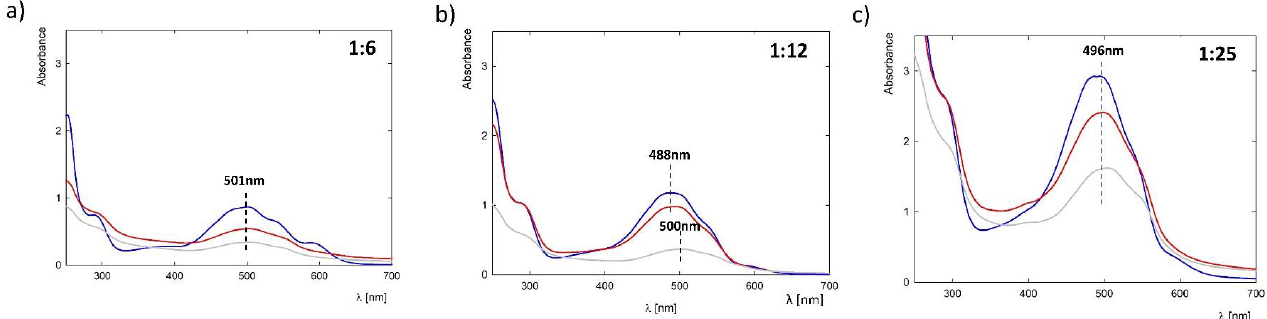
Figure 6. UV-Vis spectra of G4PAMAM-DOX complexes with pH 9.5 for selected G4PAMAM-DOX molar ratios: ( a ) 1:6, ( b ) 1:12, and ( c ) 1:24 (blue line: starting complex, red: 24 h of mixing, and gray: after dialysis). Table 2. Doxorubicin concentrations in G4.0 PAMAM-DOX complexes (pH = 9.5) after dialysis depending on the molar ratio of carrier/drug in terms of the number of DOX particles per dendrimer particle (N DOX/PAMAM ), loading content (LC), and encapsulation efficiency (EE). Molar